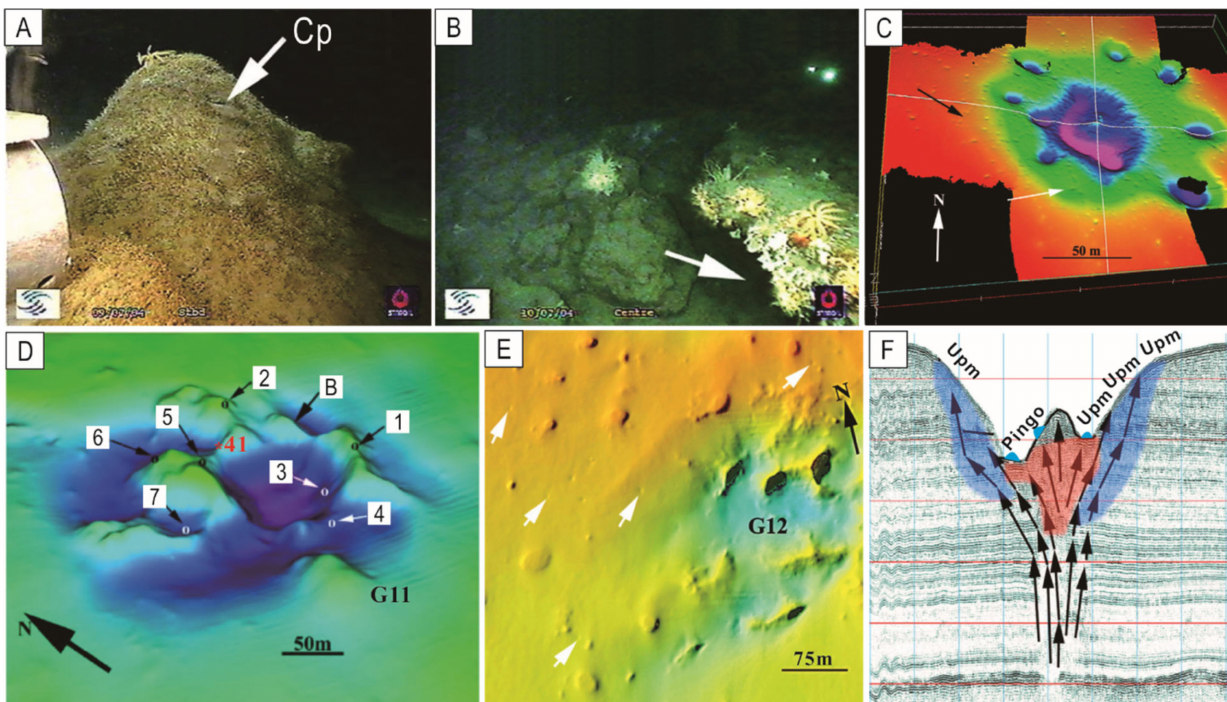
Figure 10. ( A ) Video-grabbed image of a near-perfect hydrate pingo covered by thin sediments and small bacterial mats. (Note: Cp represents corrosion pit). ( B ) Between two large carbonate blocks, two small hydrate chunks (arrow) are located. ( C ) A typical sample of a “pockmark family” comprising one large normal pockmark located in the center, with seven satellite pockmarks surrounding it, and numerous unit pockmarks (arrow). ( D ) Hydrate pingoes (Nos. 1–7) and bacterial mats are found near and on carbonate ridges in Pockmark G11. (Note: “*41” is a gravity core bearing hydrates collected on the ridge slope; “B” represents bacterial mat). ( E ) Pockmark G12 and numerous unit pockmarks (arrows). ( F ) Fluid flow conduits (black arrows) beneath a normal pockmark. Trapped gas (red) suffers the overpressure below the authigenic carbonate to contribute to the formation of pingoes on the ridges, whereas overpressured pore water (blue) drives the formation of unit pockmarks (Upm). The arrows in left bottoms of figures C and D point north ( A and B are cited from [54]; C , E , and F are cited from [60]; D is modified from